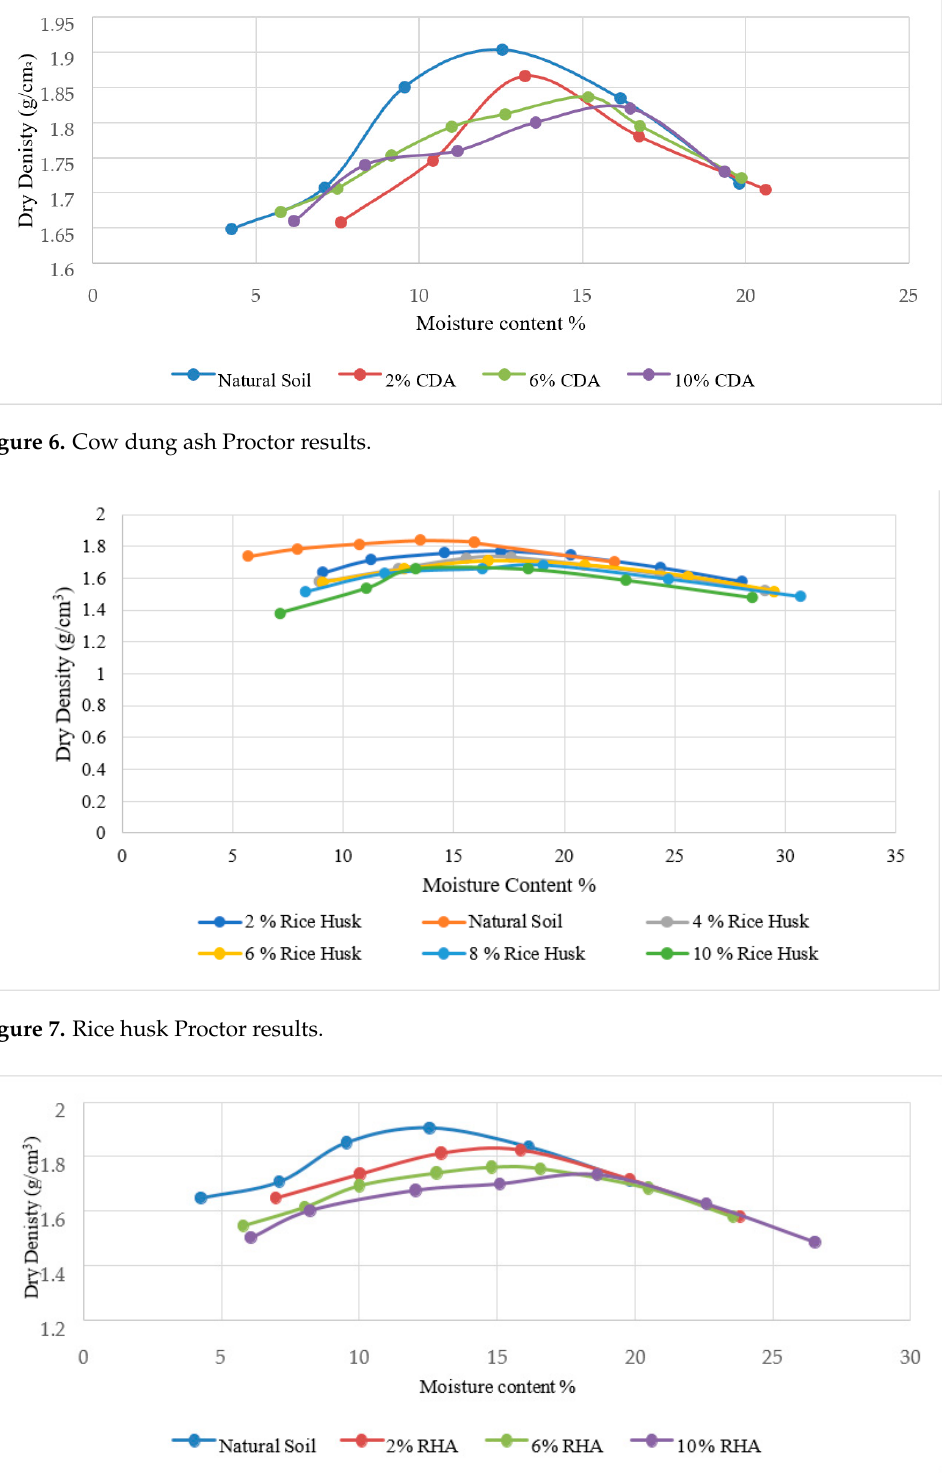
Figure 9. Saw dust Proctor results. Figure 10. Marble dust Proctor results.